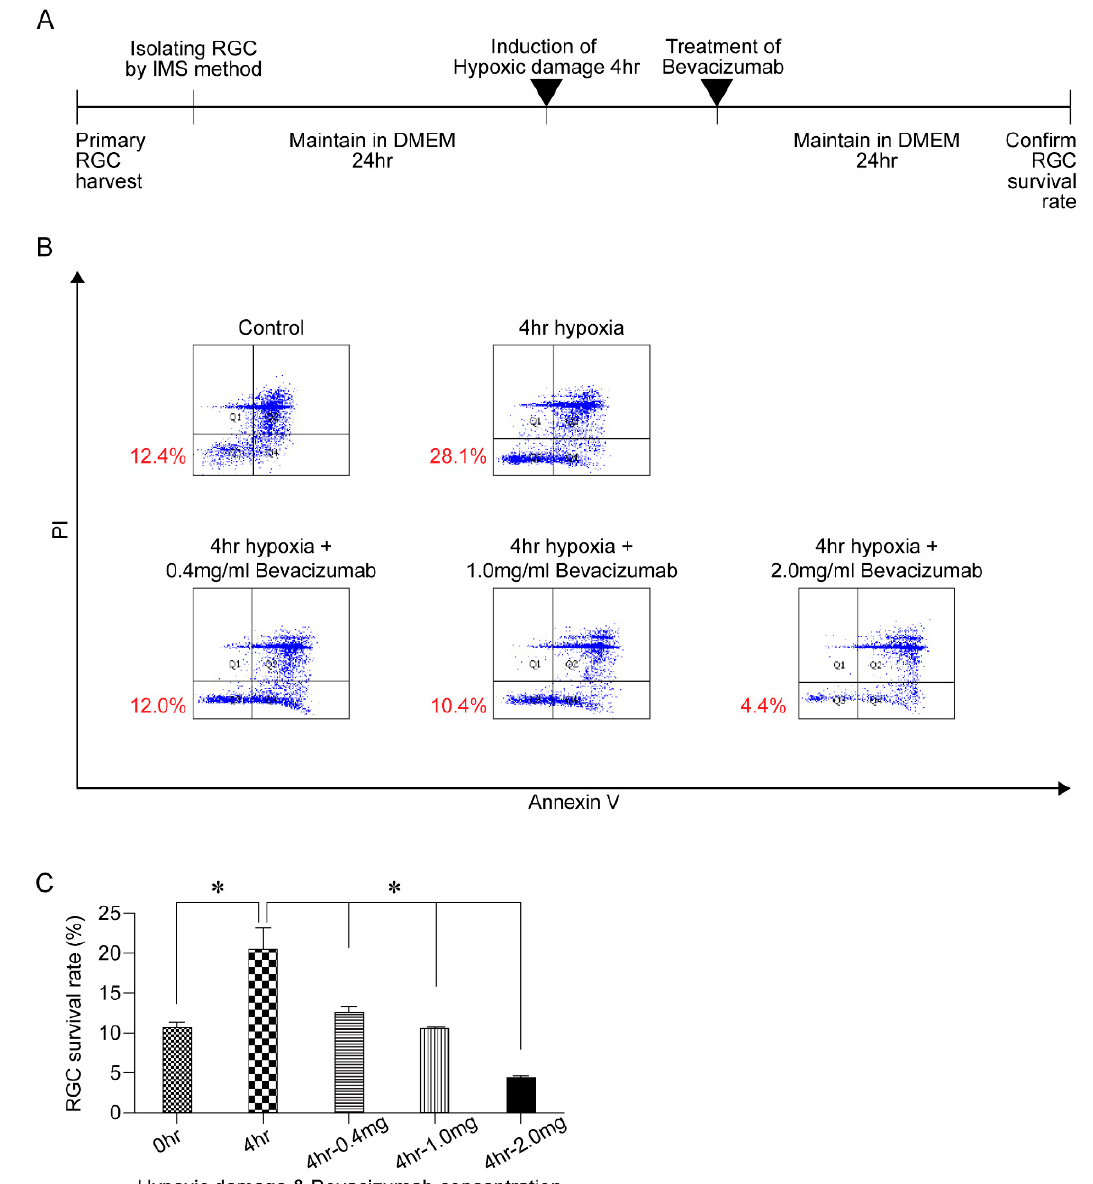
Figure 5. Effects of antivascular endothelial growth factor (VEGF) antibody on retinal ganglion cell (RGC) survival after hypoxic preconditioning (HPC). ( A ) After harvesting, primary RGCs were maintained for 24 h in a defined medium; then, the cells were subjected to HPC for 4 h in a CO 2 chamber. Thereafter, different concentrations of bevacizumab (0.4, 1.0, and 2.0 mg/mL) were added to the samples. RGCs were maintained for another 24 h in a defined medium and cell survival was compared among the groups. ( B , C ) Using flow cytometry, the cells that survived HPC were verified and quantified. Data in the columns indicate the mean survival rate ± SD. Statistically significant difference from the 4-h HPC-treated cell group is indicated (* p < 0.05).